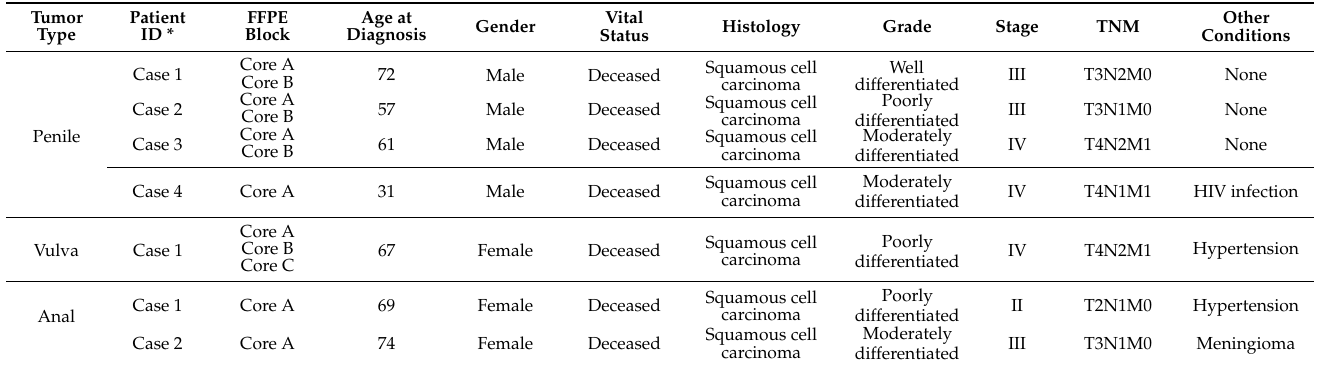
Table 1. Clinical and demographic information of the case series of anal, vulvar and penile cancer included in this